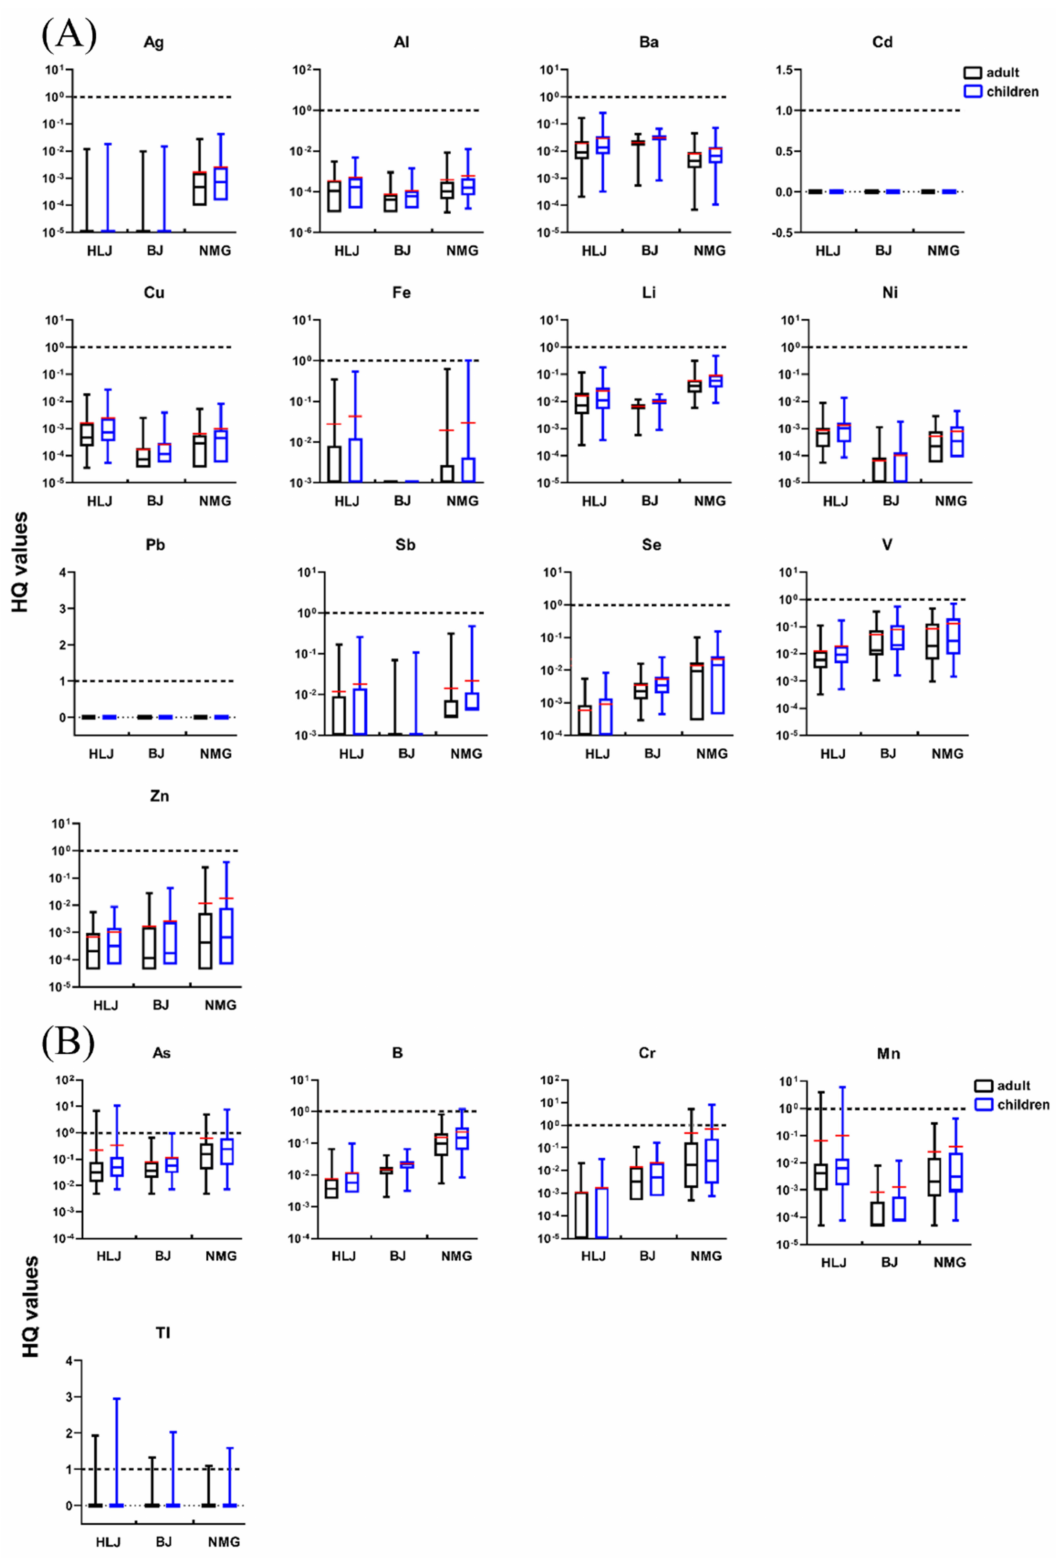
Figure 5. Non-carcinogenic risk of heavy metals by ingestion of wells water for adults and children: ( A ) HQ < 1 and ( B ) HQ > 1. The red line is the average value. The black dotted line is HQ value of 1. For HLJ, 2.82% (2/71), 1.41% (1/71), and 2.82% (2/71) of the HQ values for As (HQ As ), Mn (HQ Mn ), and Tl (HQ Tl ), respectively, were greater than 1 for adults.